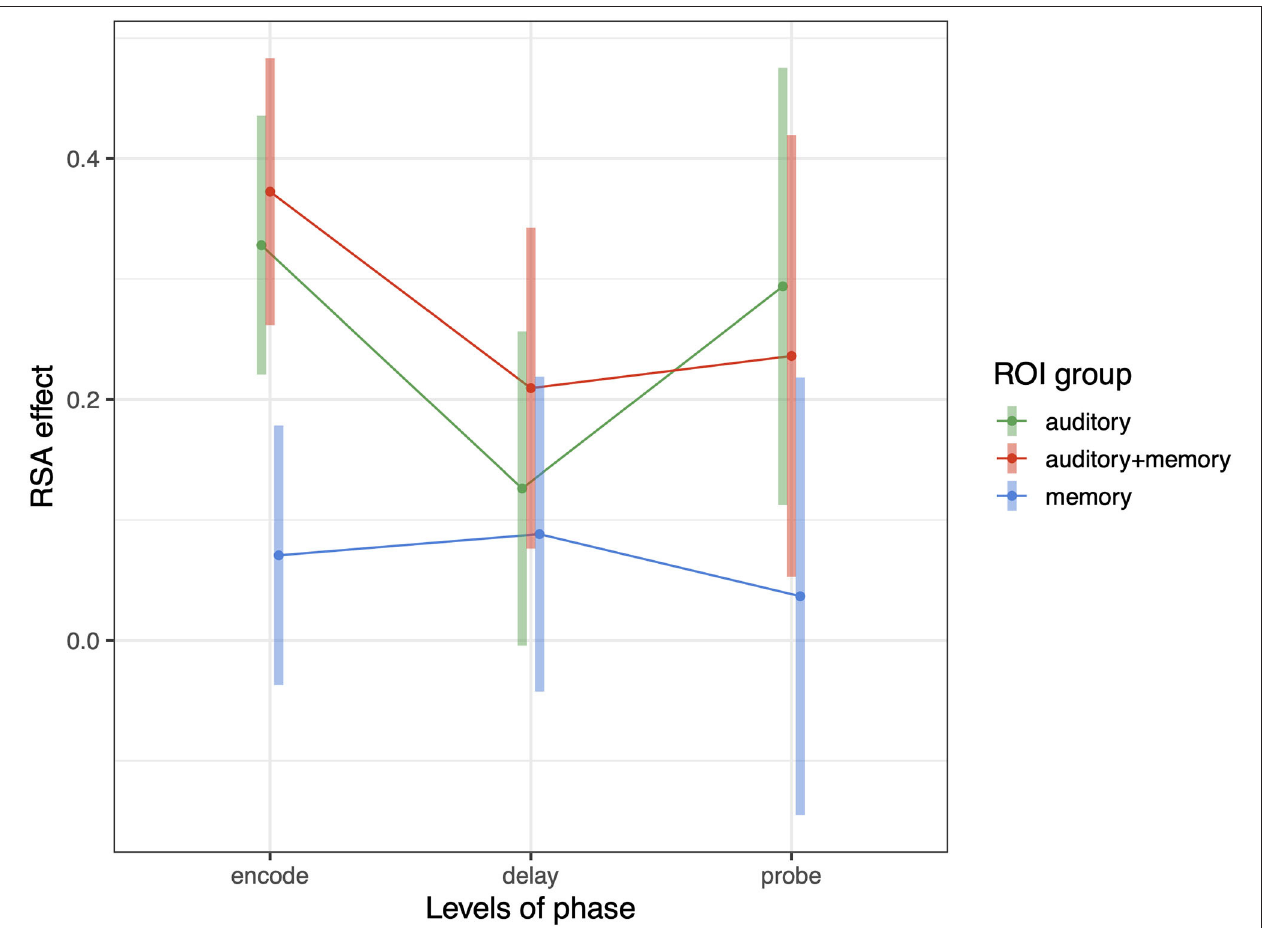
FIGURE 7 | Average RSA effect in each of three ROI groups: auditory, auditory + memory, and memory. Error bars are 95% confidence intervals.